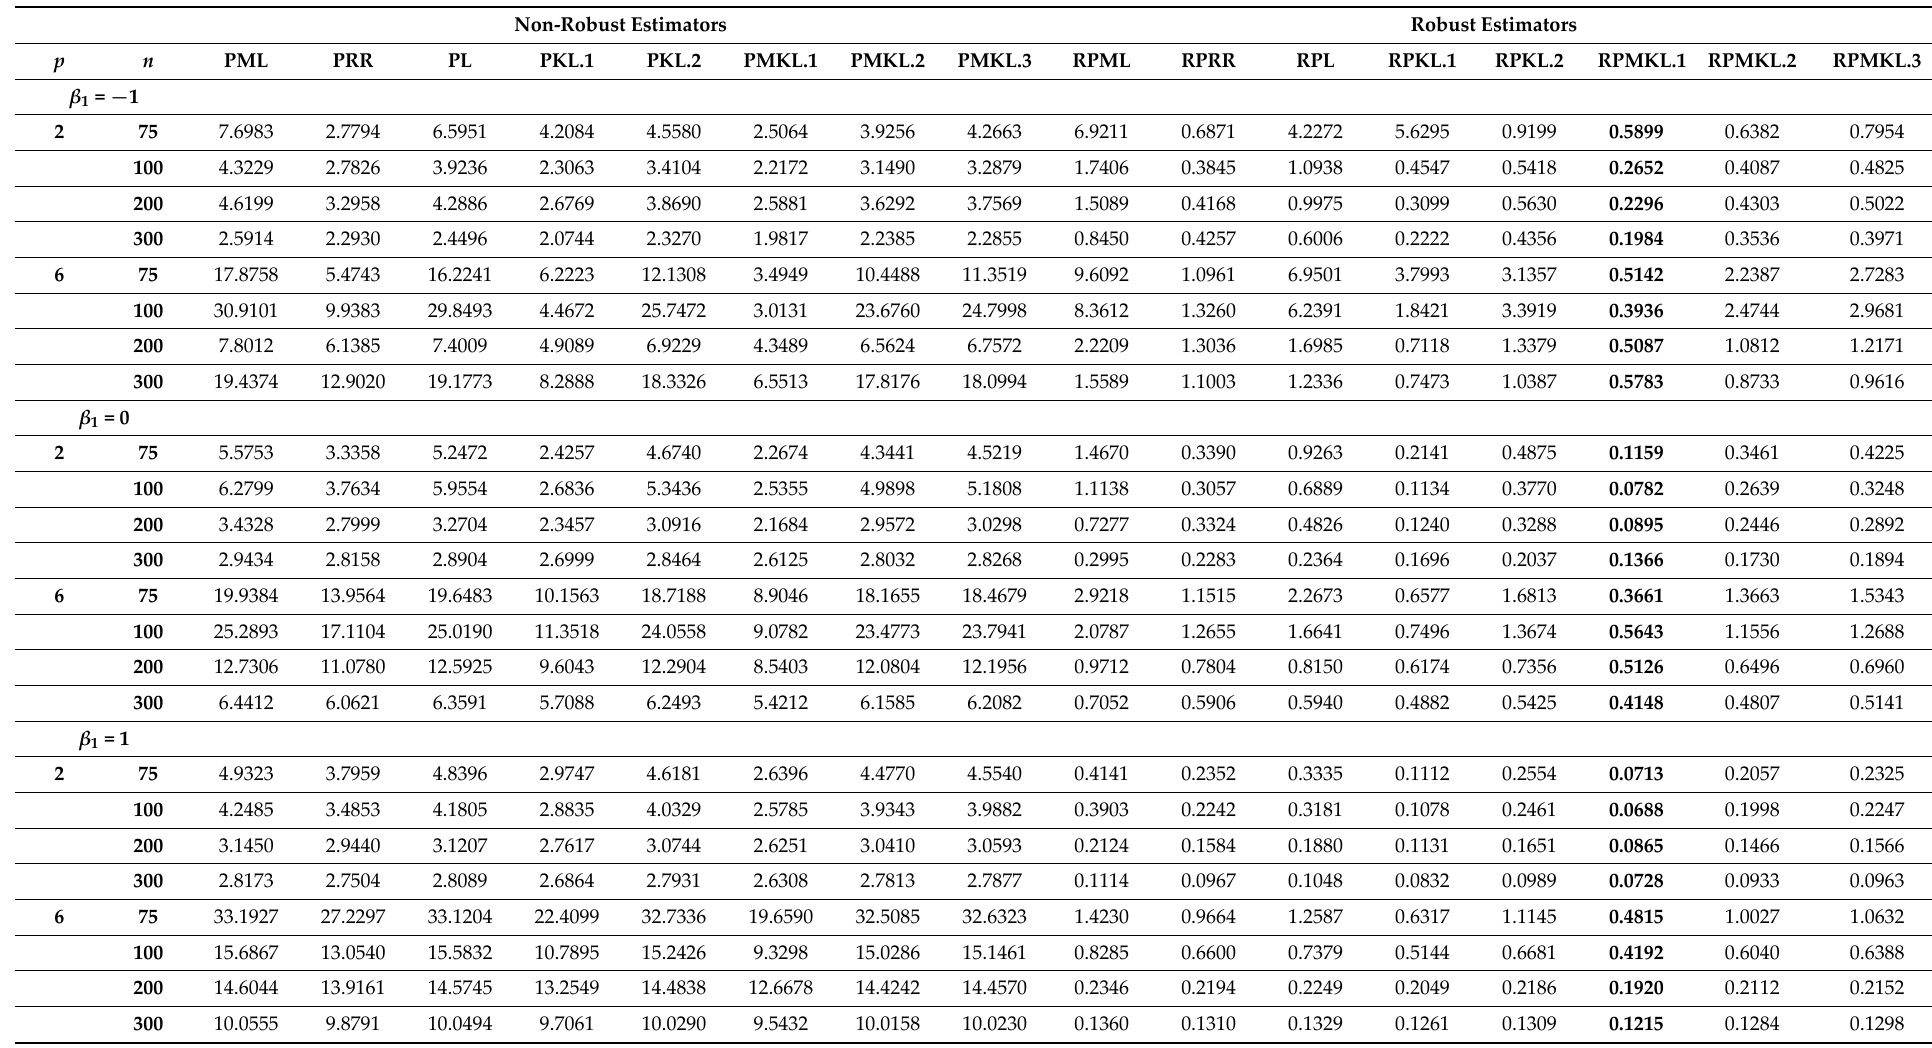
Table A6. AMSE of different estimators when τ = 10% and ρ =